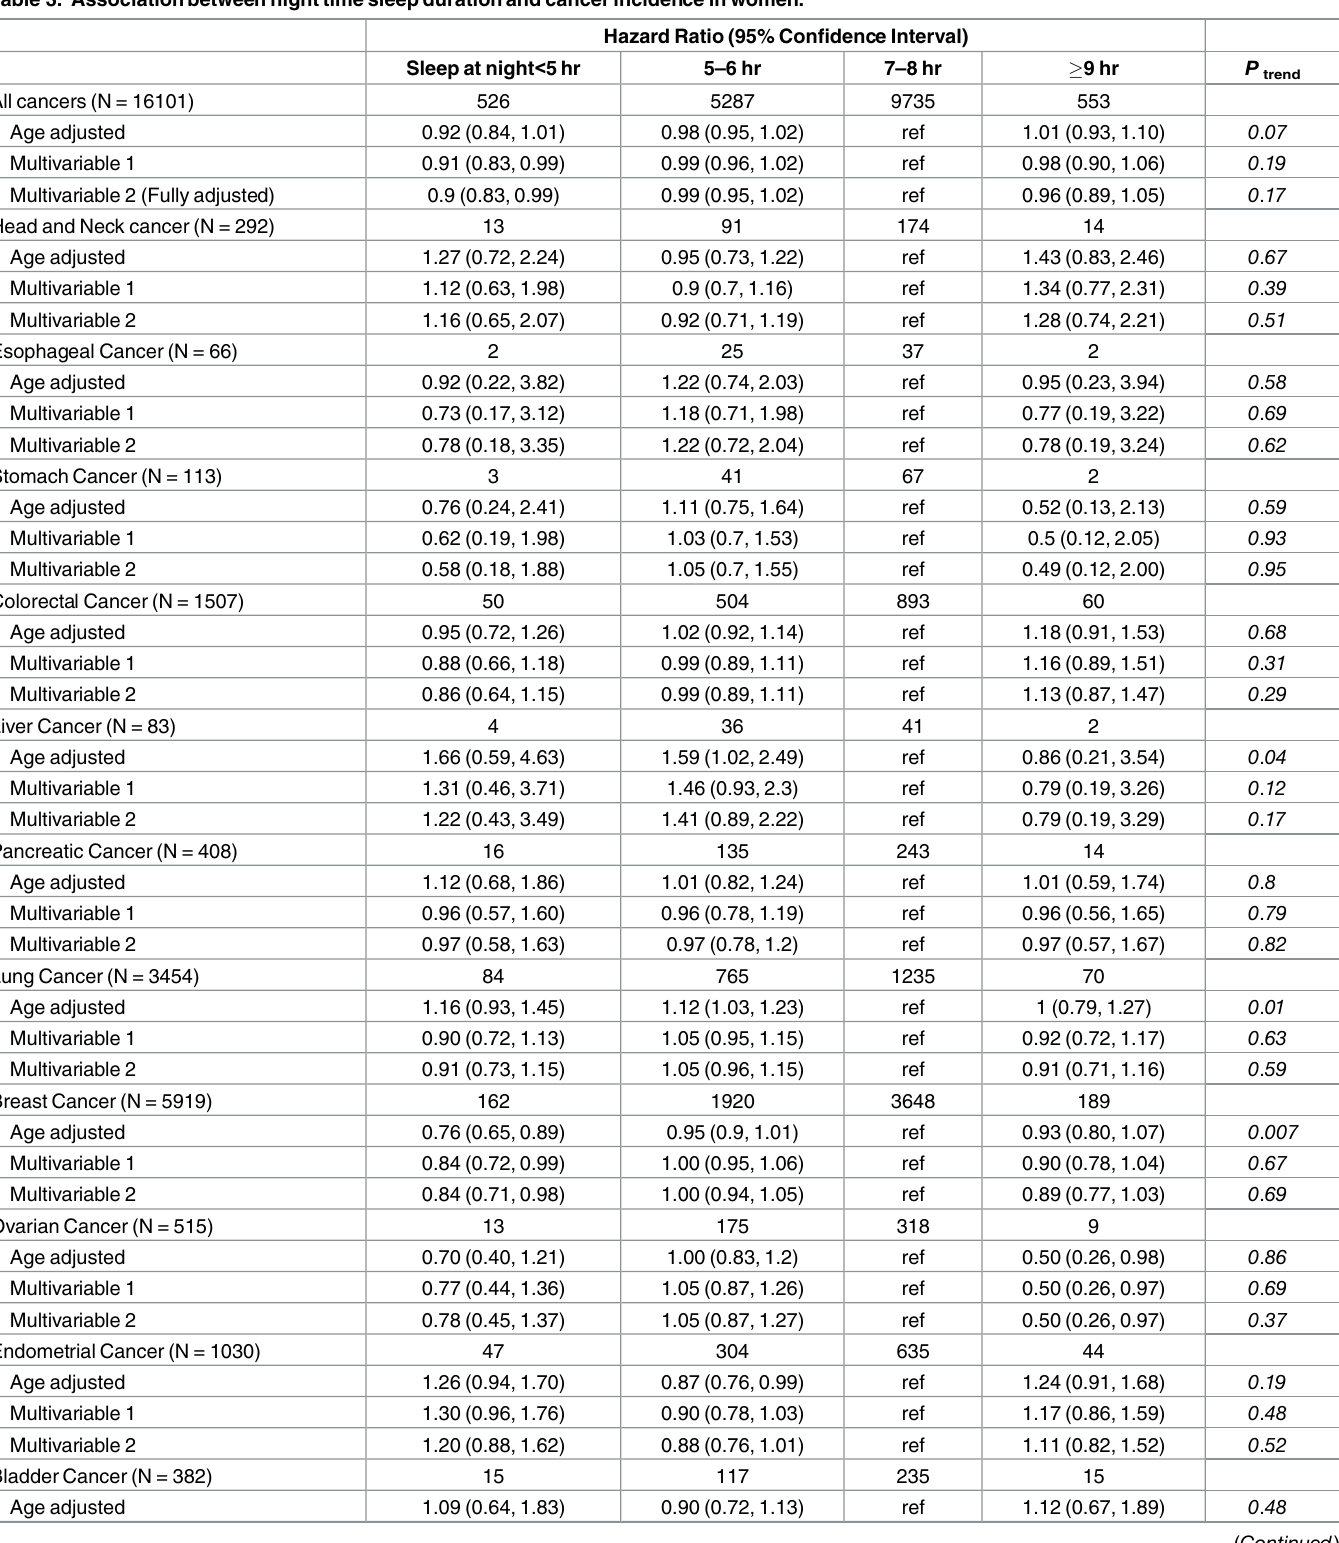
Table 3. Associationbetween nighttime sleepdurationand cancerincidence in